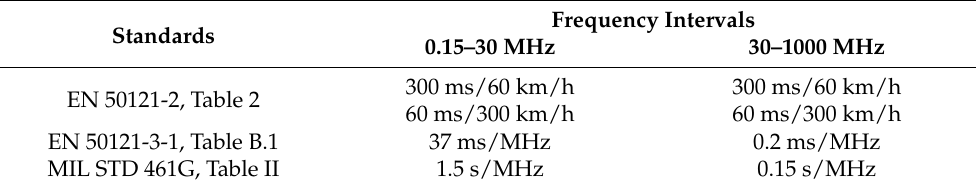
Table 2. Sweep time values (EN 50121-2, EN 50121-3-1, and MIL STD